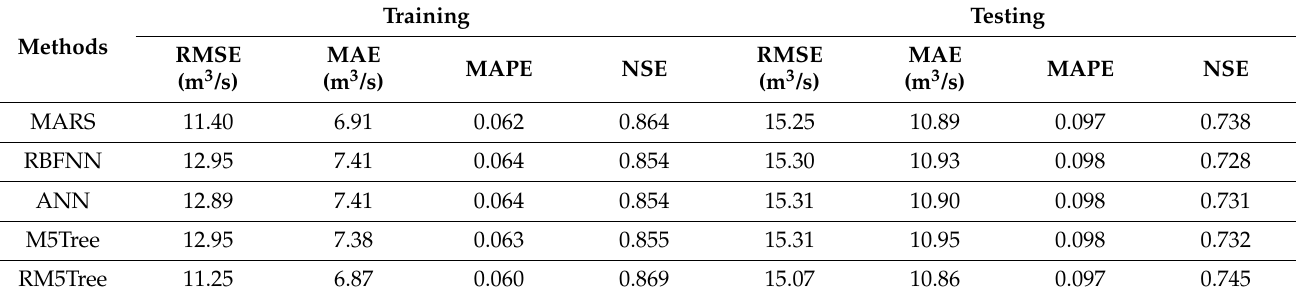
Table 5. Training and testing statistics of the RM5Tree, M5Tree, RBFNN, ANN, and MARS models in daily streamflow prediction using the optimal inputs of Qt − 1 and Qt − 2—Skallbole